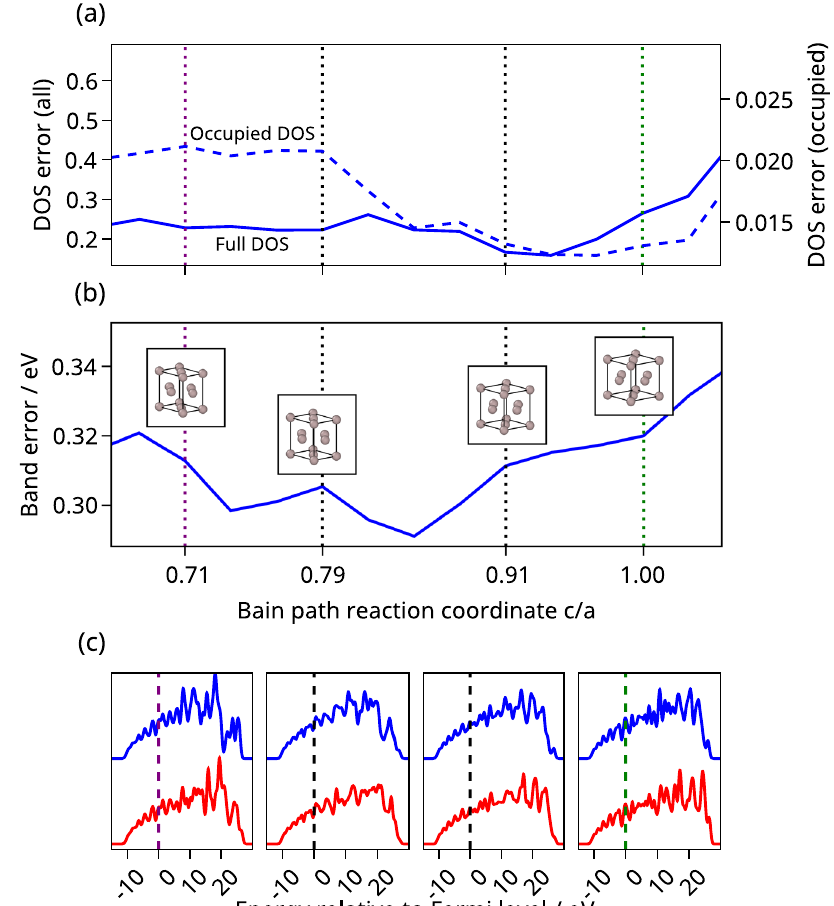
ffiffiffi p (cid:2) 0 : 71 to FCC c / a = 1. a Error in the density of states made by our Fig. 7 Electronic structure along the transition from BCC c = a ¼ 1 = 2 ACE model with respect to the DFT reference (measured with the Wasserstein distance) as a function of c / a along the Bain path. The solid line shows the full error in the DoS (right vertical axis), while the dashed line shows the error in the occupied states (left vertical axis; note the change of scale). b RMSE error in the electronic band structure (along high-symmetry k -path for the BCC structure) as a function of c / a along the Bain path. Insets illustrate the structure of the cubic cell at points along the path. c Comparisons of densities of state for the ACE model (blue) and DFT (red) at four points along the path, including the BCC (left) and FCC (right)